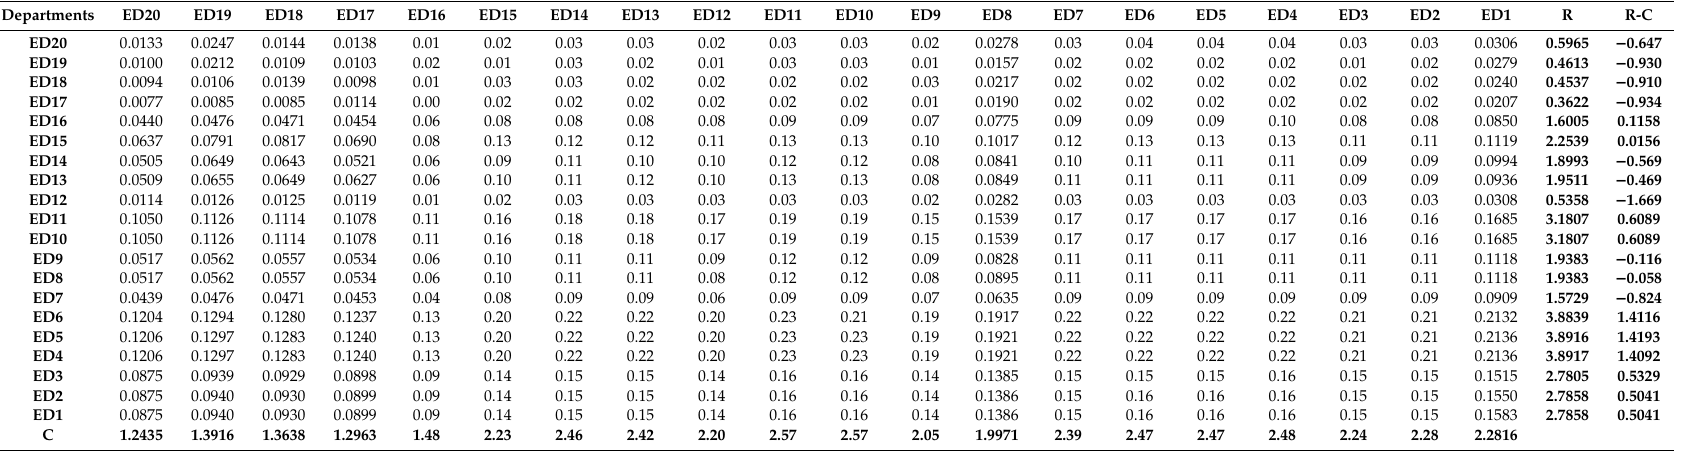
Table 2. Matrix of Decision-Making Trial and Evaluation Laboratory (DEMATEL) to evaluate interrelationships among existing departments based on infection risk for the rearchitecting of the Bahonar